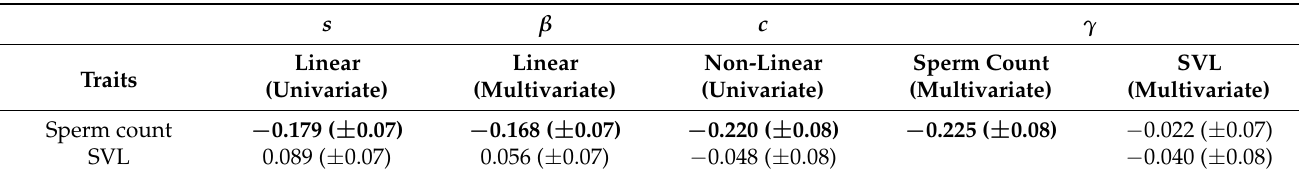
Table 2. Linear and non-linear selection differentials and gradients ( ± SEM) from univariate and multivariate selection analyses on body size (SVL) and sperm count. Estimates were obtained using ordinary least-squares regressions with relative fitness (number of offspring sired relative to population mean) as the dependent variable, and standardized male sperm traits and their quadratic terms as the independent variables (separate models were fit for linear and non-linear selection estimates). Significance of selection gradients was determined using generalized linear models with a quasi-Poisson distribution and a log link. Estimates with p < 0.05 are bolded.